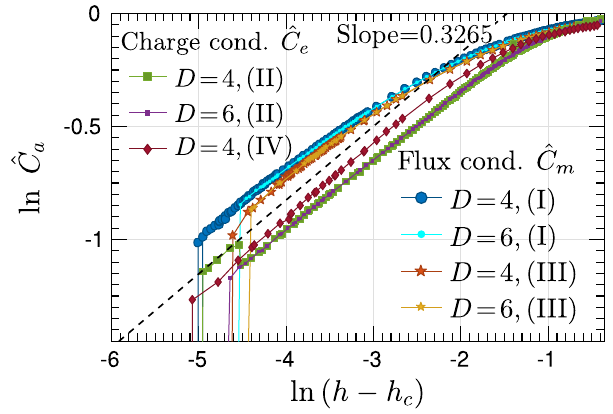
FIG. 6. Scaling of condensate fractions close to the critical point for the lines I – IV. The slope matches the critical exponent β ≈ 0 . 3265 of the order parameter of the 3D Ising